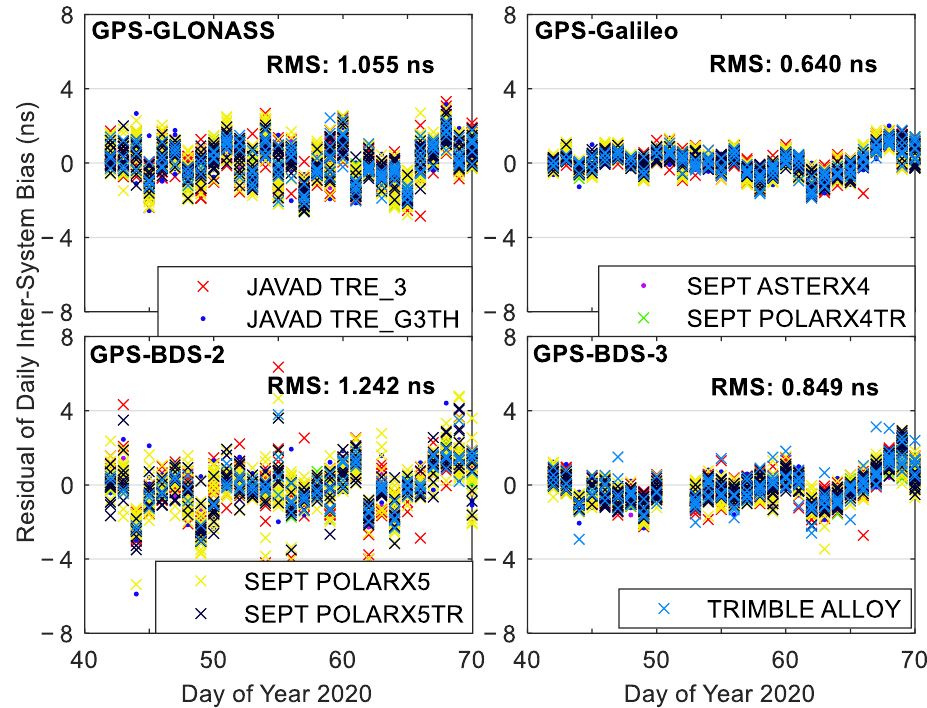
Figure 9. Prediction residuals of daily ISBs with a time span of prediction of a day for each station (characterized by the receiver types).